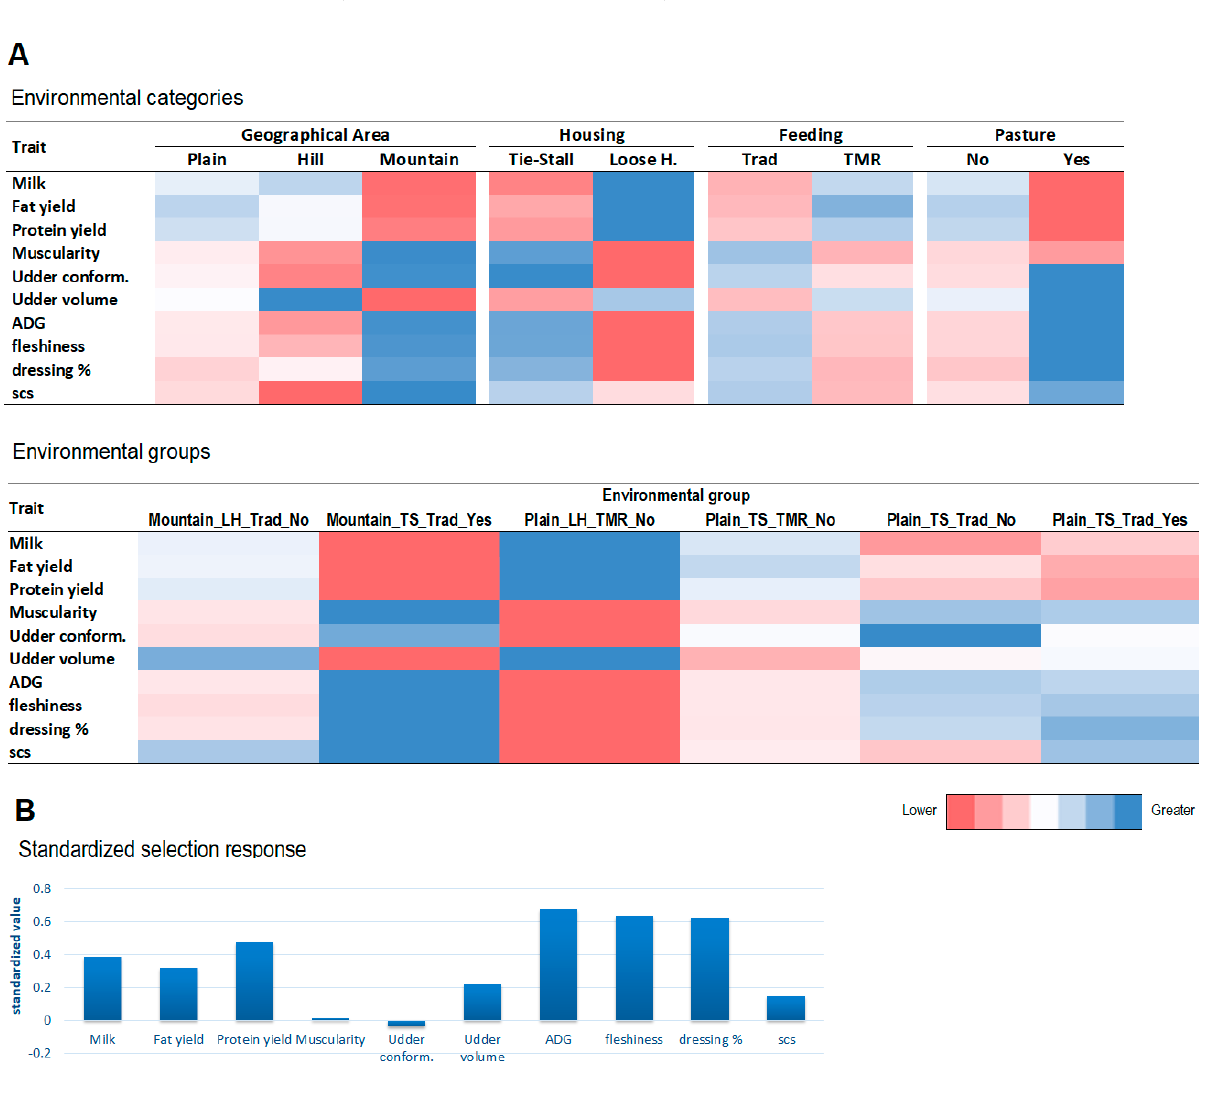
Figure 5. ( A ) Multivariate response to selection for traits included in Rendena selection index by levels of environmental categories and by environmental groups 1 . Values of response are shown as gradient of colors. The gradient has to be seen within trait (that is, line by line). ( B ) Relative genetic increase in traits, in terms of standardized selection response.